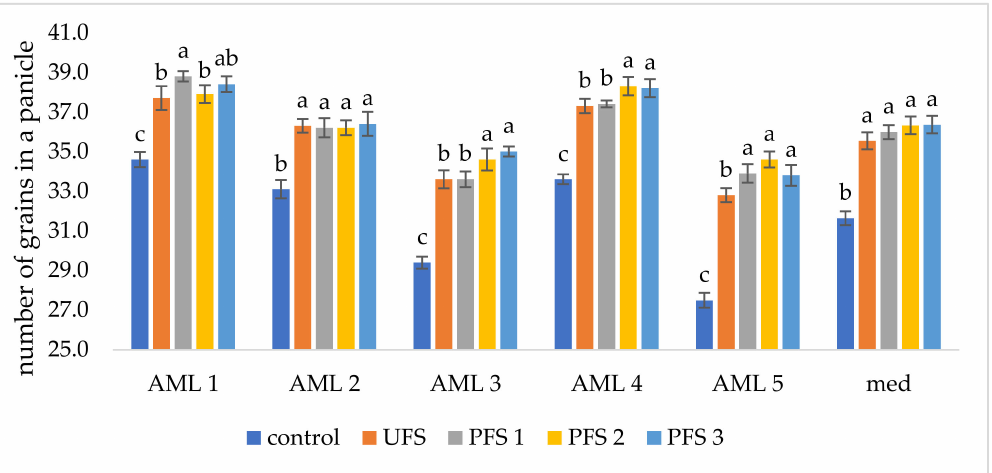
Figure 10. The number of grains per oat panicle in the experiment. The different letters represent statistically significant ( p ≤ 0.05) differences between the tested options of fertilizer application. Error bars show the standard deviation of the mean value ( n = 15). AML 1 is the eluvial agricultural microlandscape, AML 2 is the eluvial-accumulative agricultural microlandscape, AML 3 is the transit- eluvial agricultural microlandscape, AML 4 is the accumulative agricultural microlandscape, AML 5 is the accumulative agricultural microlandscape. Control is the option without fertilizers, UFS is the uniform application of organic and mineral fertilizers, PFS 1 is the differentiated application of organic and uniform application of mineral fertilizers, PFS 2 is the differentiated application of mineral and uniform application of organic fertilizers, PFS 3 is the differential application organic and mineral